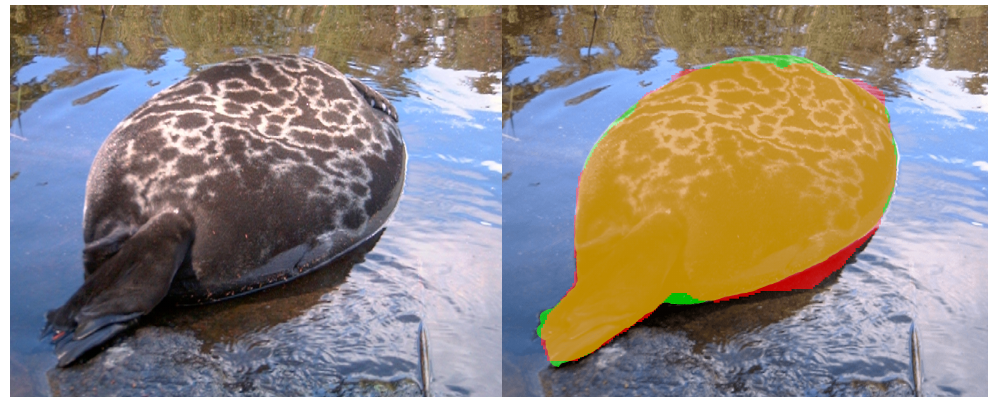
Figure 5. Segmentation mask example. The green color depicts the ground truth, red is the segmenta- tion result, and yellow is the